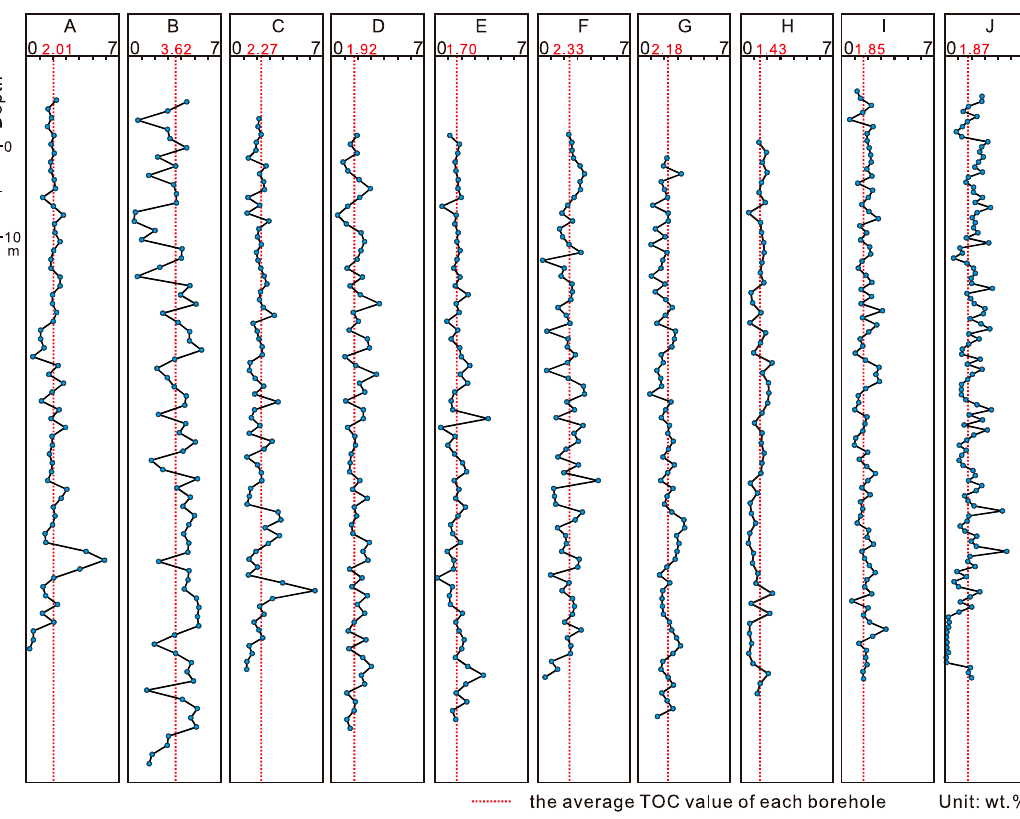
Figure 2. Vertical distribution of the total organic carbon (TOC) of selected boreholes in the Gulong Sag (The distance between the two TOC values is 1 m).